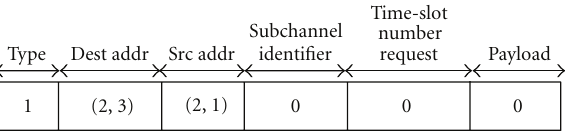
Figure 15: SEM-TDM outgoing set-up packet allocator EAST